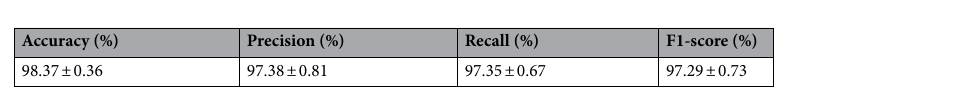
Table 3. Classification results for the ResNet18 architecture (six classes: normal (16-HBE), A-427, A-549, H-1975, SK-LU-1, and PC-9 cell-lines). Values are mean ± standard deviation for five experimental